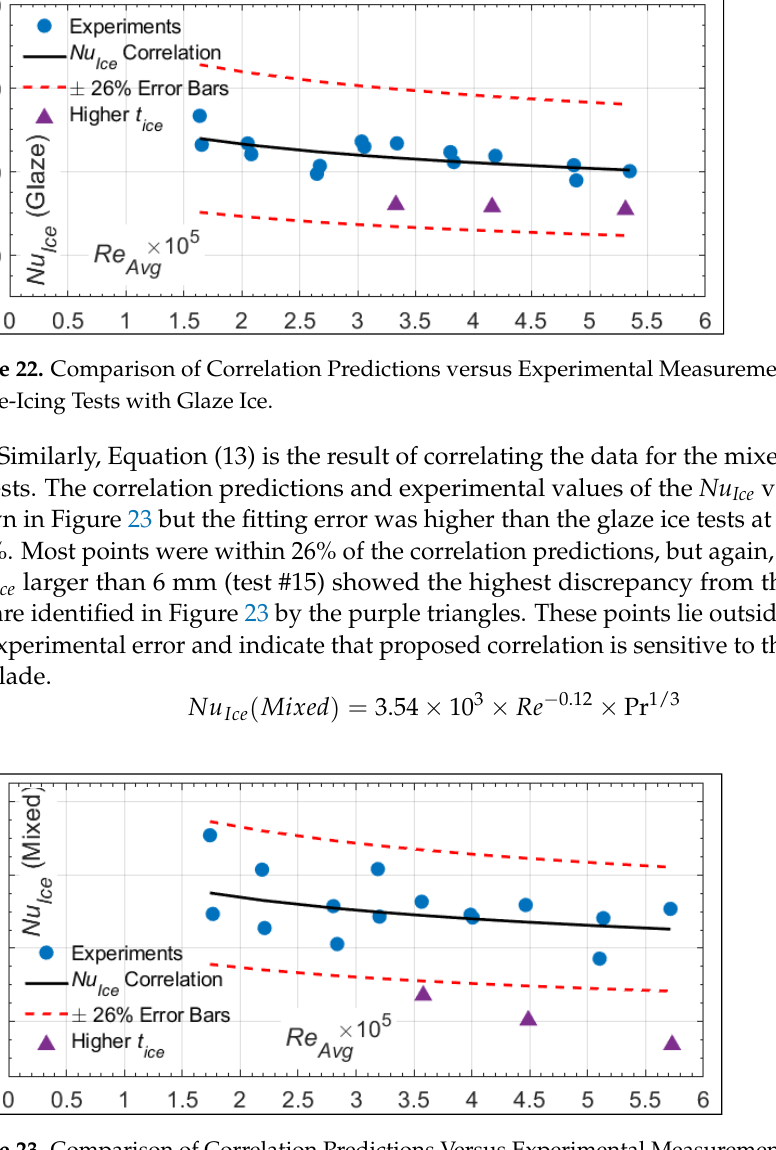
Figure 23. Comparison of Correlation Predictions Versus Experimental Measurements for the Nu Ice for the De-Icing Tests with Rime Ice.